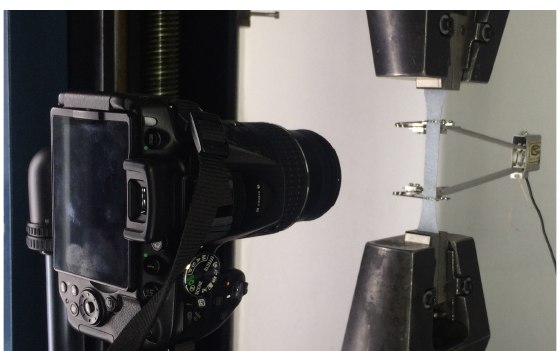
Figure 2. Tensile test